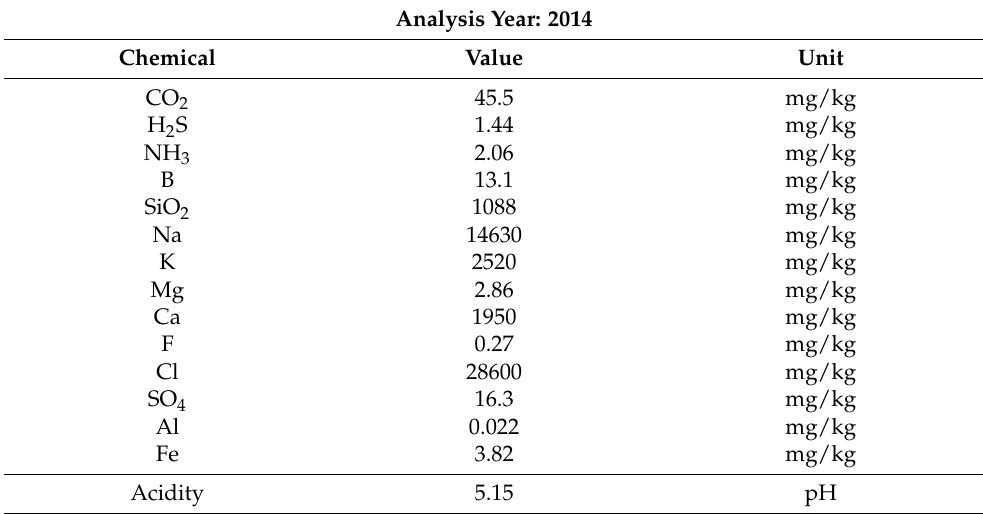
Table 1. Chemical composition of the liquid phase of well RN-29 at Reykjanes geothermal powerplant. Analysis Year: